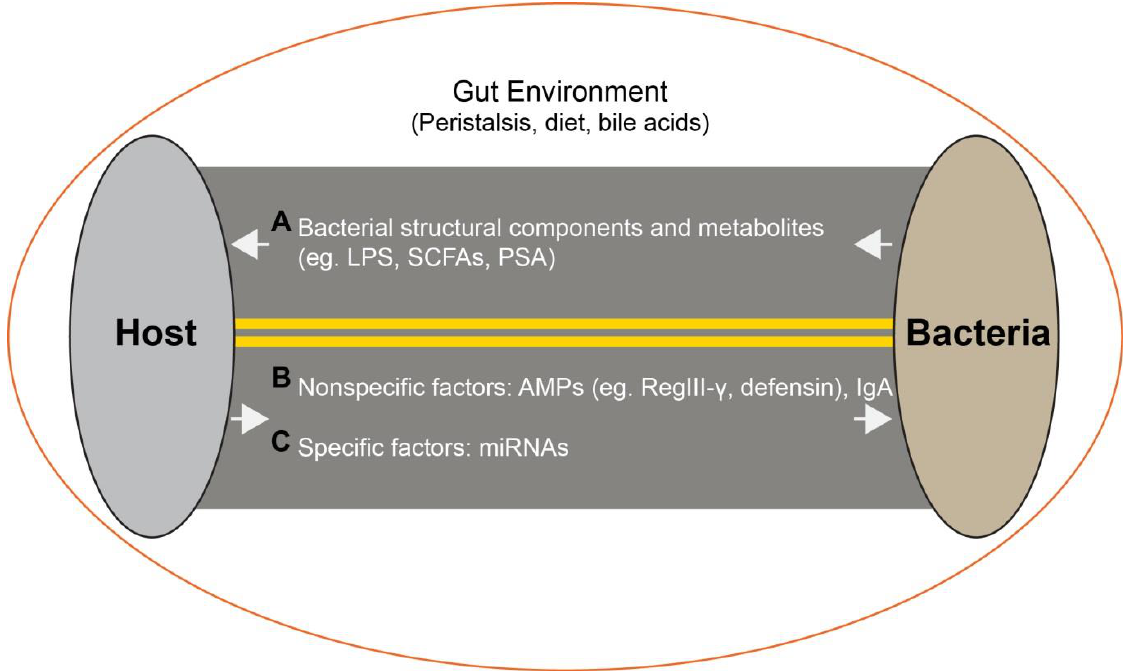
FIGURE 1: Microbe-host interactions in the gut lumen. (A) Bacterial to host mediators. (B) Non-specific host to bacterial mediators. (C) Spe- cific host to bacteria